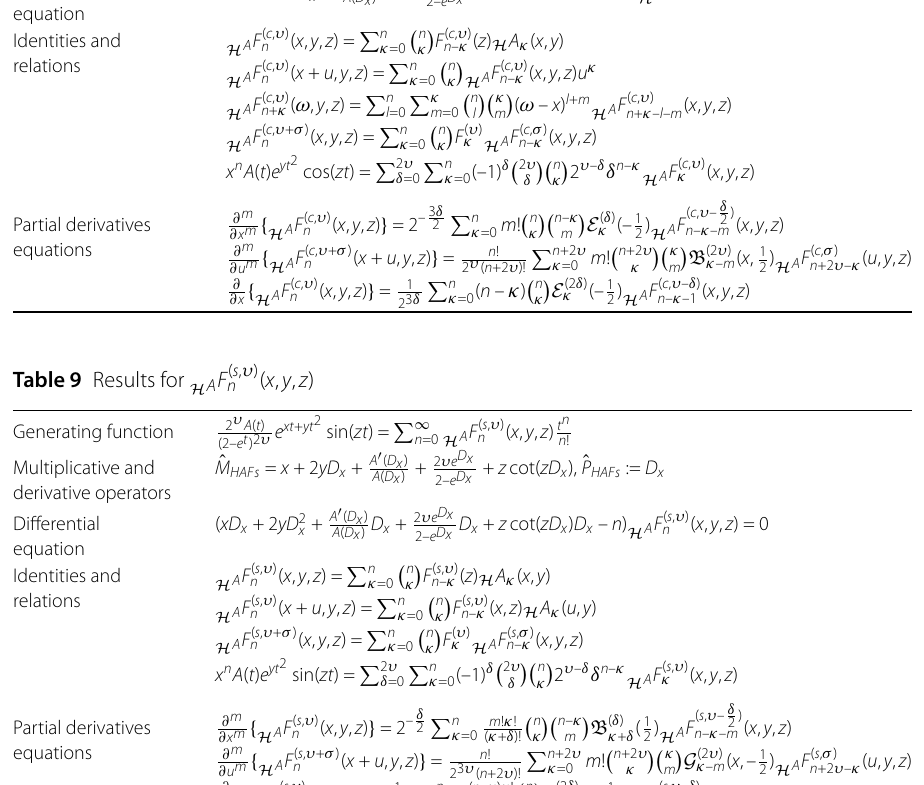
Table 8 Results for Generating function